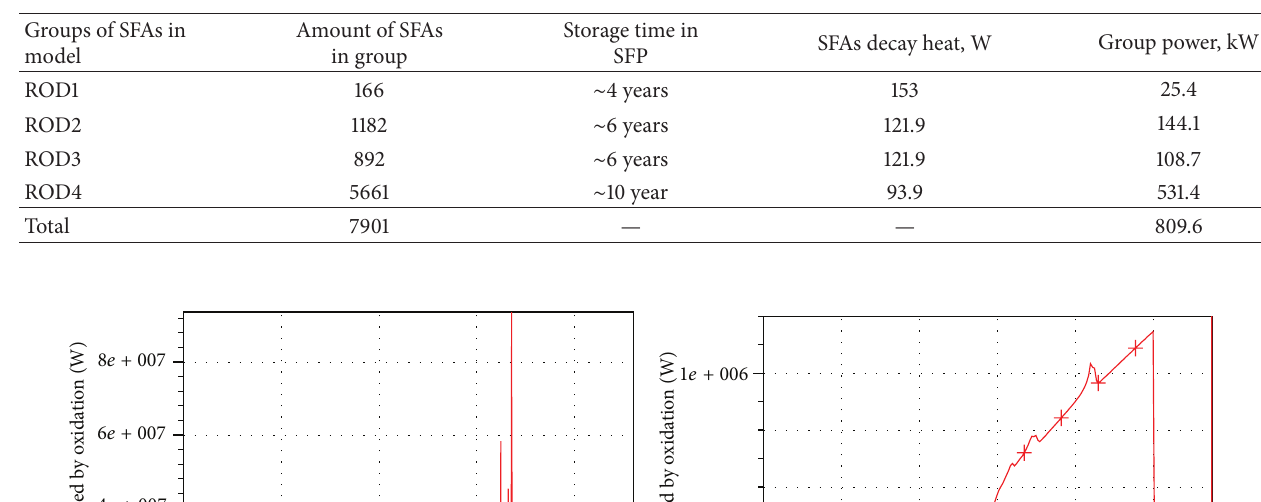
Table 3: Parameters of SFA in SFP (today situation).